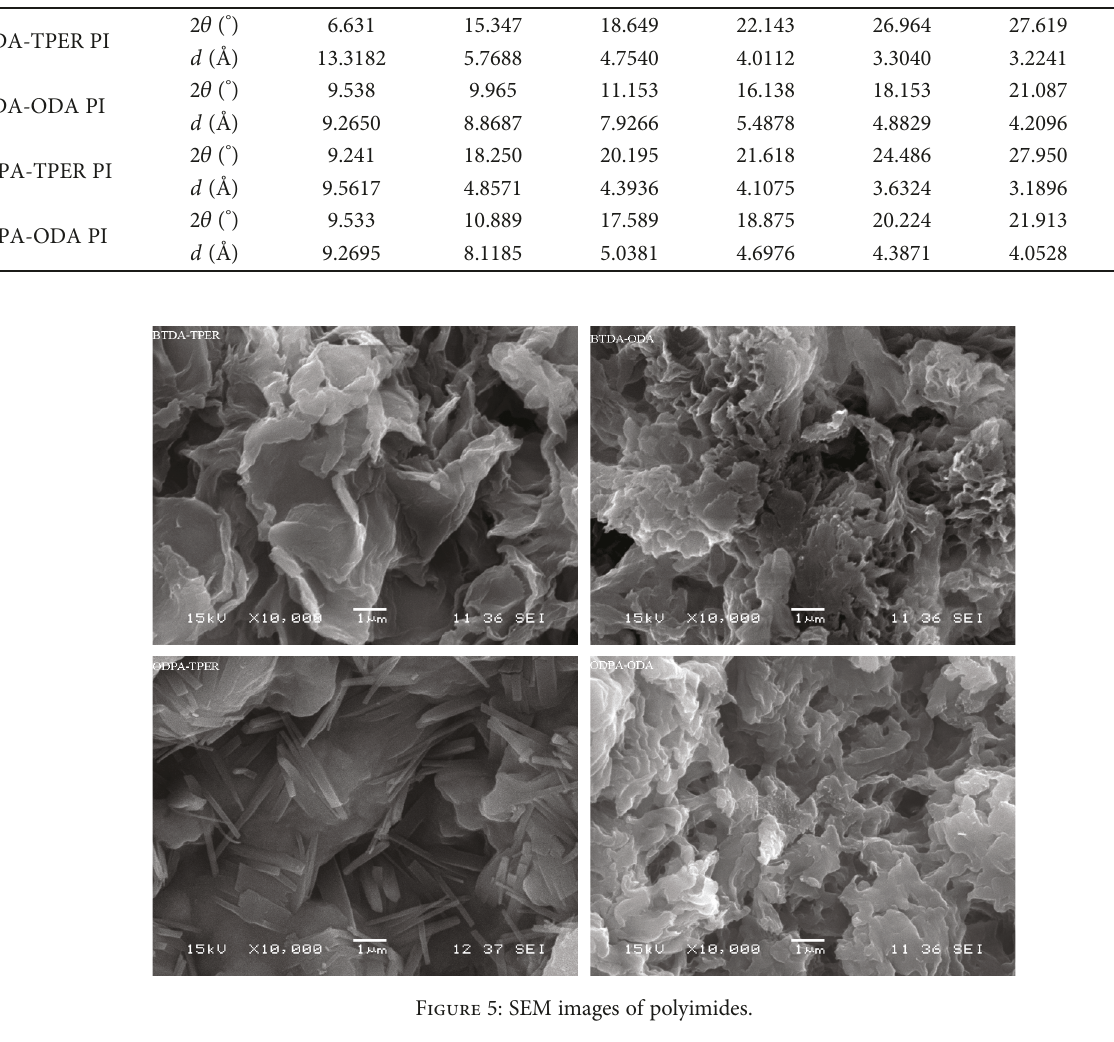
Table 2: XRD parameters of polyimides.